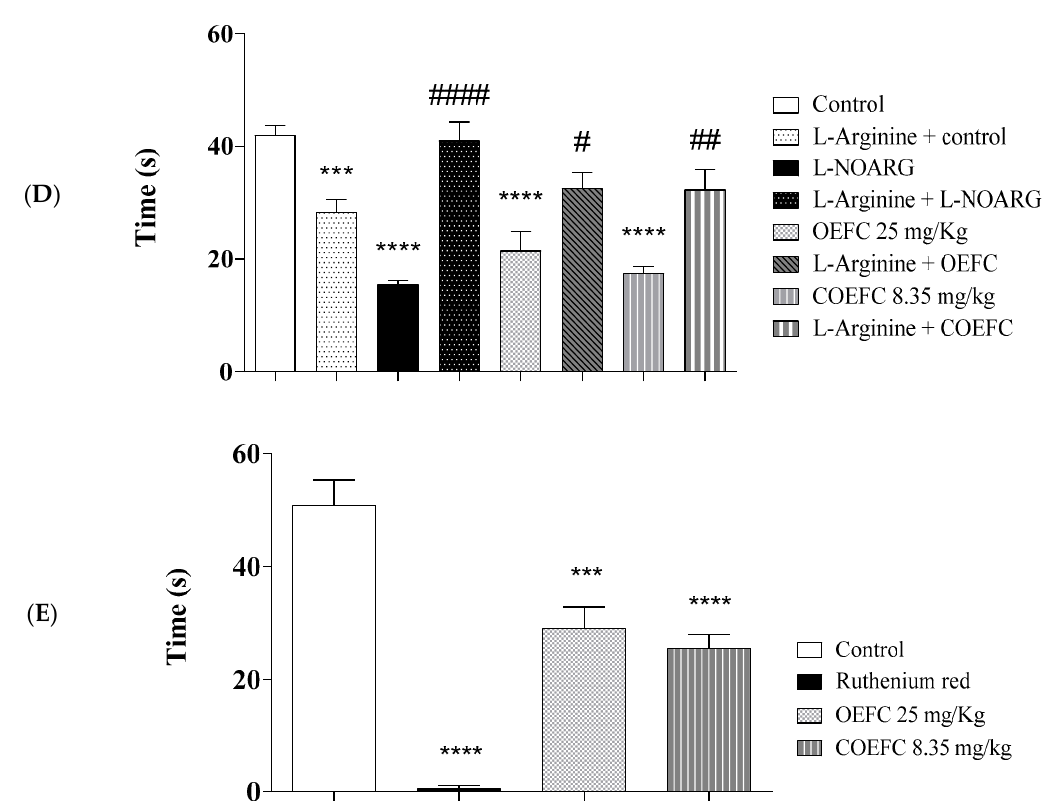
Figure 6. Pain signaling pathways involved in the antinociceptive response of OEFC (25 mg/kg) and COEFC (8.35 mg/kg) (opioid, cholinergic, α 2 adrenergic, nitric oxide, and vanilloid) ( A – E ). Involvement of the opioid, cholinergic, vanilloid, α -2 adrenergic receptor, and L-arginine/nitric oxide/cGMP pathway in the OEFC (25 mg/kg/v.o.) and COEFC (8.35 mg/kg/v.o.) antinociceptive activity in the formalin-induced paw nociception in mice. Values represent the mean ± S.E.M. (standard error of the mean) for groups of 6 animals, where * p < 0.05, ** p < 0.01, *** p < 0.001, and **** p < 0.0001 when compared to the control group; # p < 0.05, ## p < 0.01, ### p < 0.001, and #### p < 0.0001 when comparing the antagonist and agonist vs. agonist. Statistical analysis: ANOVA followed by Tukey´s test with multiple comparisons.